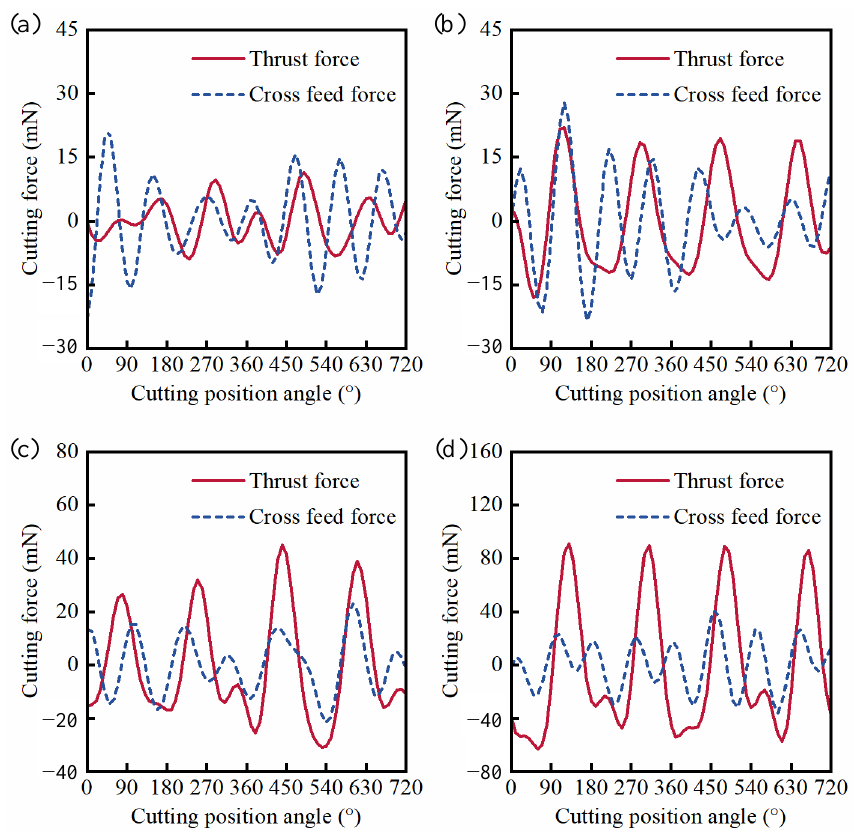
Figure 4. (Defect-free surface) Experimental results of cutting force with cutting edge rotation angle under f t / r e : ( a ) f t = 0.27 µm/z, f t / r e = 0.15; ( b ) f t = 0.46 µm/z, f t / r e = 0.25; ( c ) f t = 1.37 µm/z, f t / r e = 0.75; ( d ) f t = 5.46 µm/z, f t / r e = 3.0.